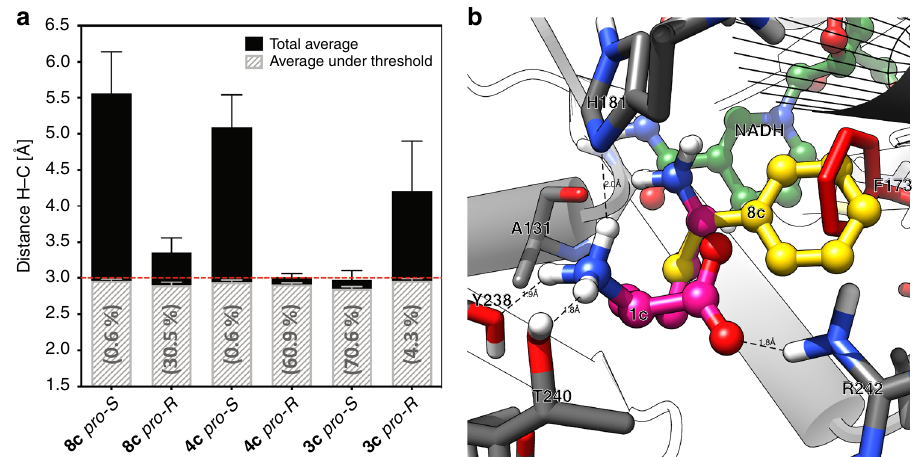
Fig. 5 Pro-chiral preferences of LE-AmDH-v1. a Total average hydride/ pro -chiral carbon distance over a minimum of 6 MD simulations and average under the distance threshold (3 Å). The percentiles indicate how often the average distance was under the given threshold. For details, see Supplementary Methods. b Superposition of the natural substrate and 8a in the active site of the wild type enzyme. The natural intermediate 1c is depicted in magenta, whereas the iminium of acetophenone ( 8c ) is depicted in yellow. The mutation point (F173A) is marked in red and the cofactor NADH is depicted in green. It can be observed that once the mutation F173A is introduced, the aromatic ring of 8c gets accommodated into the newly created hydrophobic cavity, which was previously occupied by the phenyl group of F173; that produces an inversion of the chiral preferences of this mutant towards aromatic substrates and towards substrates with (relatively) short hydrophobic chains. Source data are provided as a source data fi le. Error bars represent the